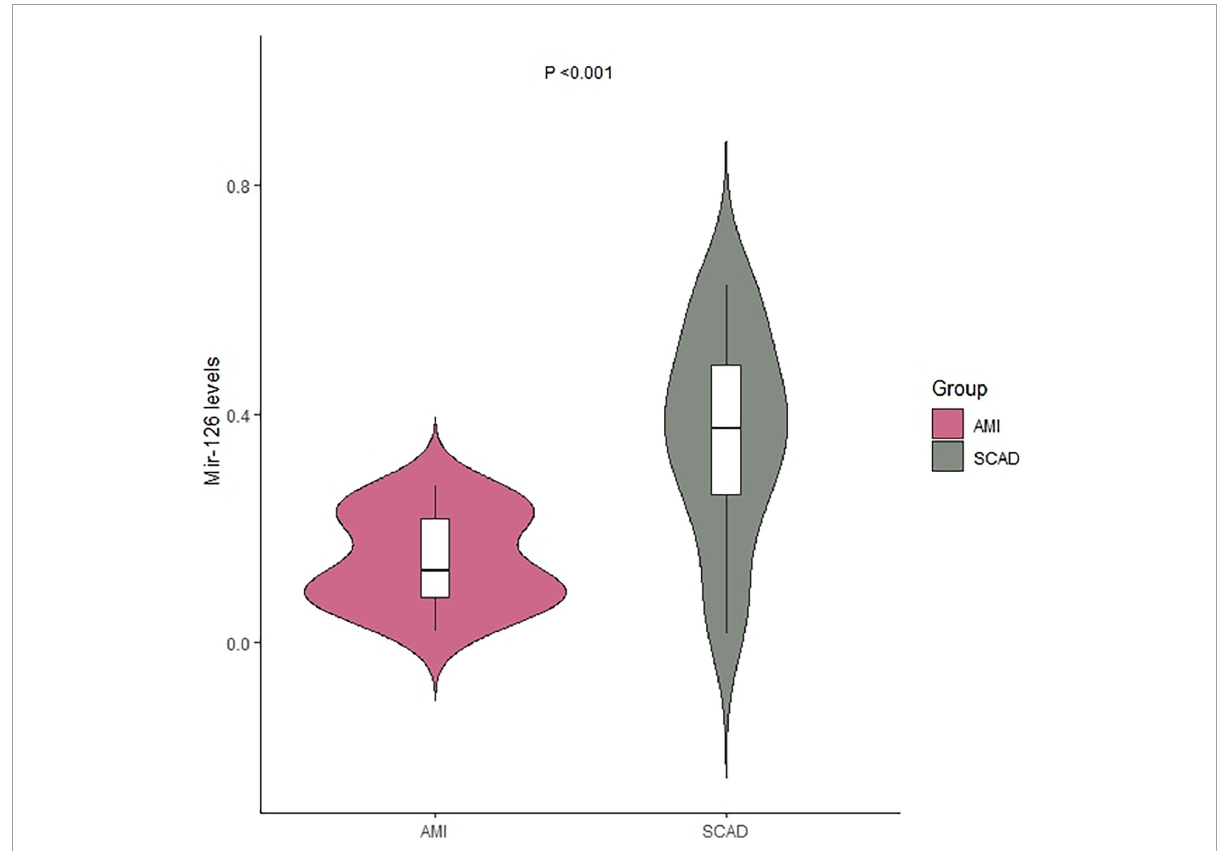
FIGURE1 Levels of extracellular vesicle-associated miR-126 in coronary blood of patients with AMI and SCAD. AMI, acute myocardial infarction; SCAD, stable coronary artery disease.